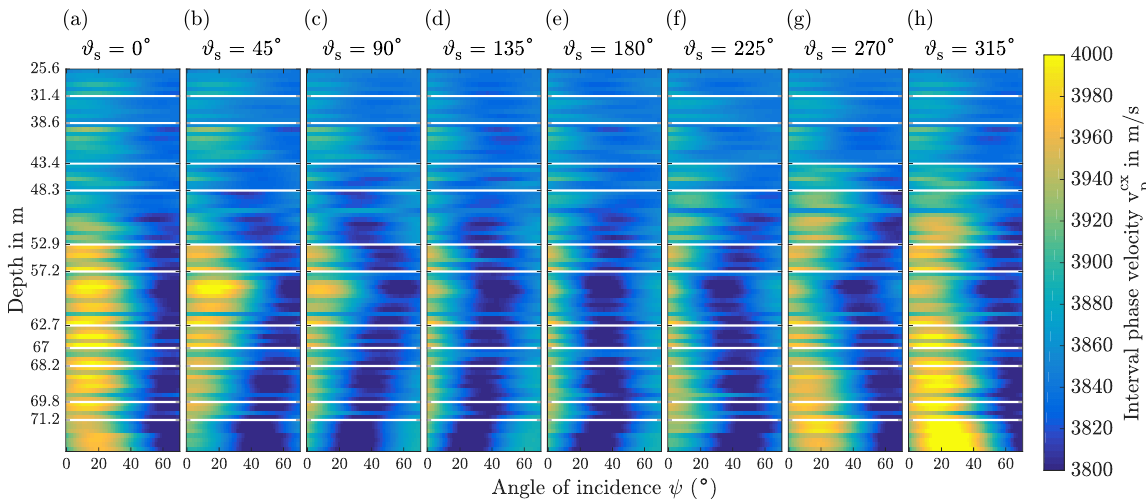
Figure 7. Seismic P-wave velocities for KCC calculated with cx framework for incidence angles up to 70 ◦ and eight seismic plane azimuth angles ϑ s . The extreme values ( v p0 = [ 3779 , 4030 ] ms − 1 ) lie in the saturated range of the colour scale, providing a better visual contrast. Note the breaks in the depth axis (white lines), where noted depth values refer to the top of the downward-extending depth interval. The thickness of the colour bands is constant for each 10cm